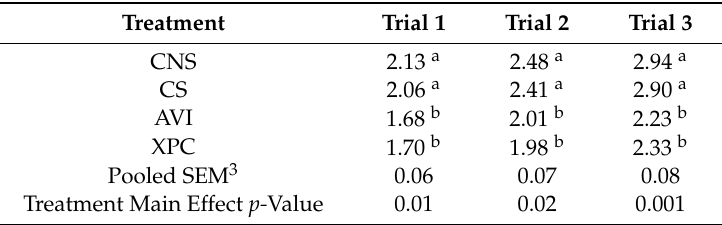
Table 3. Composite asymmetry scores (mm) after 41 days of growth 1